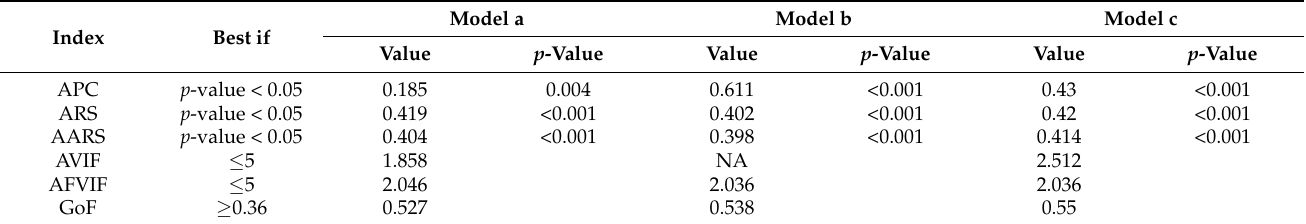
Figure 2. Evaluated models. ( a ) Simple model; ( b ) Second order model; ( c ) Mediator model. Table 4. Model fit and quality indices.